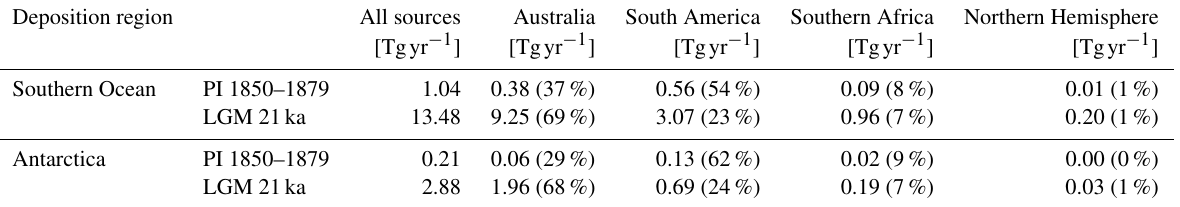
Figure 4. Results of the provenance studies showing the respective contribution of the major dust source regions South America (red), southern Africa (green), Australia (blue), and the Northern Hemisphere (yellow) to the total dust deposition in the Southern Hemisphere as a percentage (white and blue numbers; different colors were merely chosen for improved readability) for PI (a) and LGM (b) . Note that the Kerguelen Islands have been considered a dust source in the SAFonly experiment and thus appear in the same color style applied for southern Africa. Table 5. Dust deposition onto Antarctica during the PI and LGM depending on the dust provenance (in Tgyr − 1 and percent). Deposition